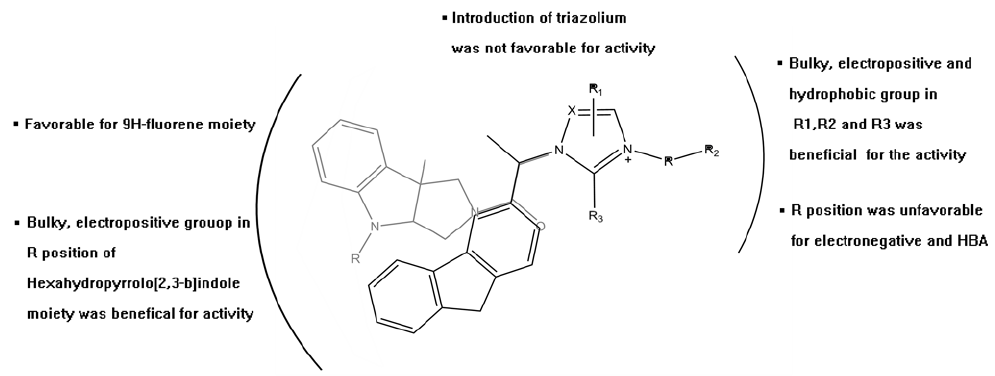
Figure 7. Structural requirements of a series of imidazolium salt derivatives demonstrate cytotoxic activity against tumor cells.